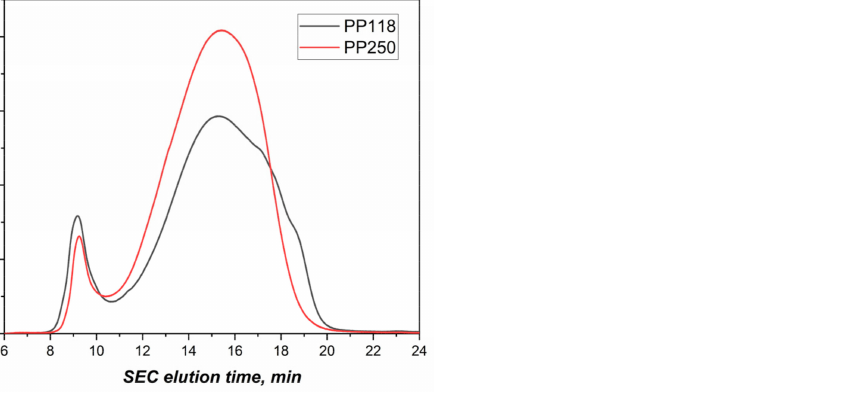
Figure 9. SEC chromatogram of two petroleum pitches with different softening points (PP118, T softening = 118 ◦ C and PP250, T softening = 250 ◦ C) adapted from